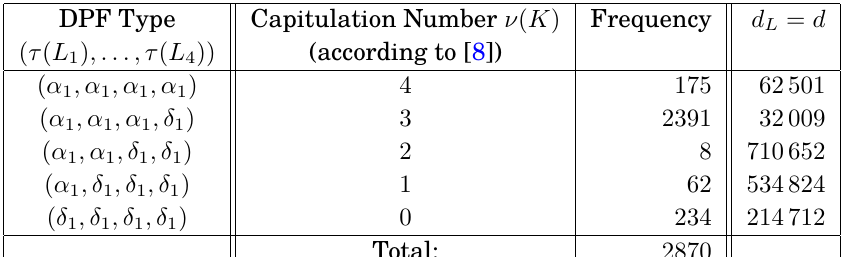
Table 16: Types of unramified quartets in the range 0 < d L < 10 7